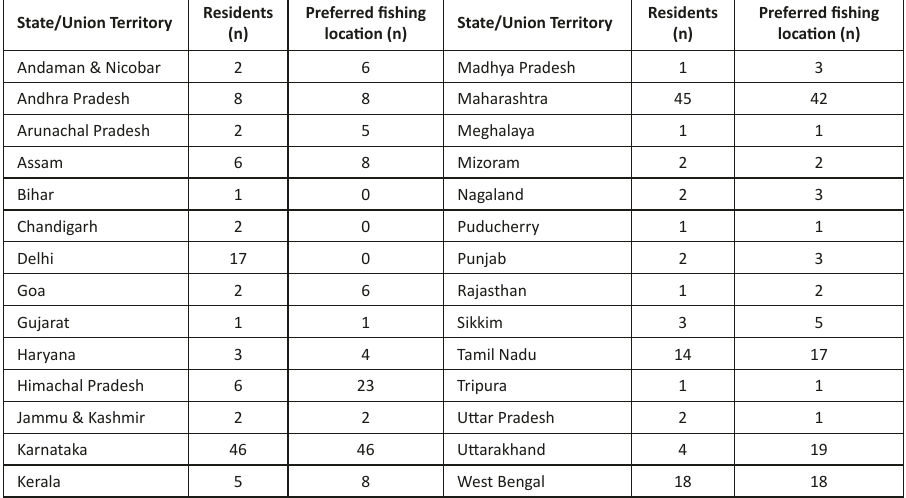
Practices and attitudes of Indian catch-and-release anglers Table 1. States/Union Territories of residence and preferred fishing locations of